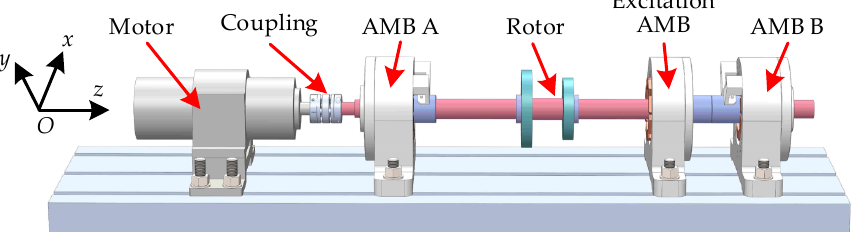
Figure 3. Three-dimensional model of the maglev high-speed motor.